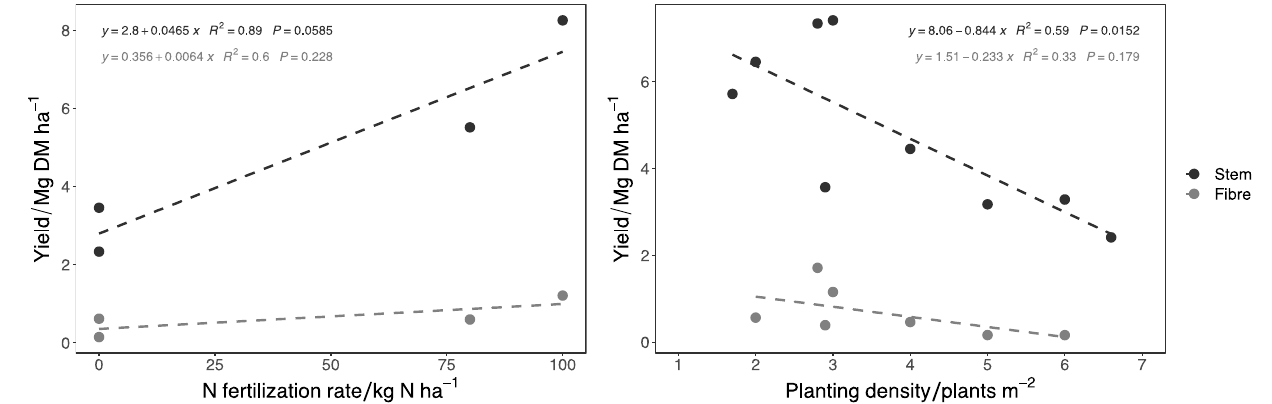
Figure 6. Nettle stem and bast fiber yield (Mg DM ha − 1 ) as affected by N fertilization and planting density in published peer-reviewed studies listed in Table 2. Dotted line represents linear regression for the data. Data of spontaneous nettle were excluded from the analyses, as well as mean values representing only 1 study in planting densities higher than 7 plants m − 2 [150].